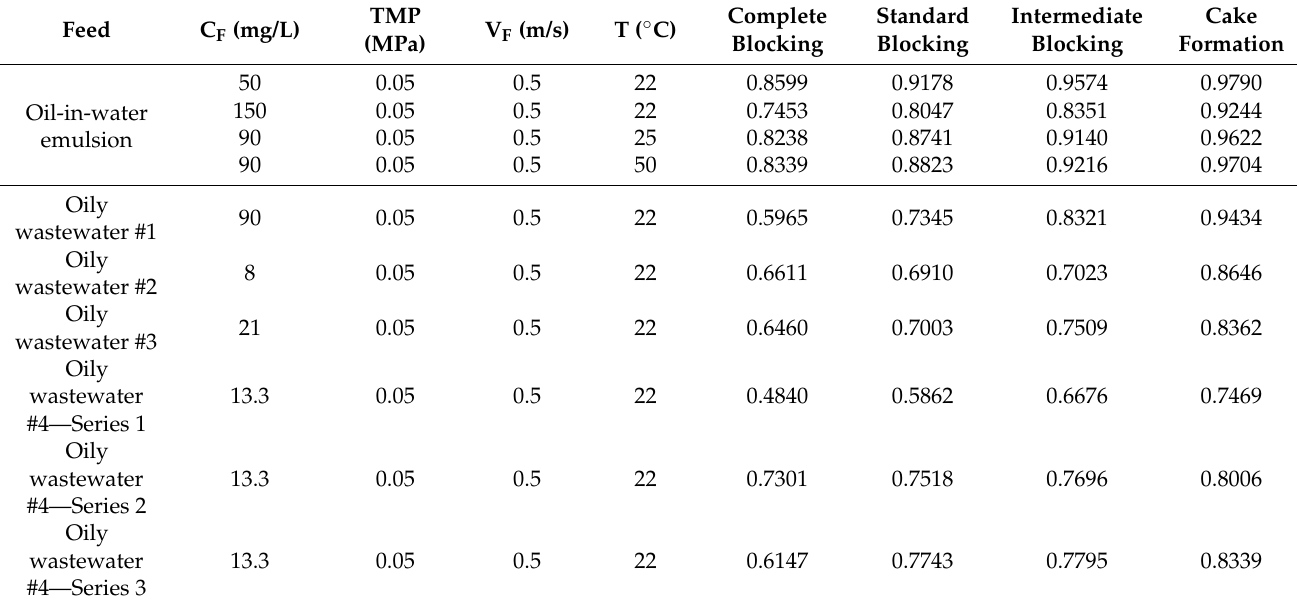
Table A1. Coefficients of determination ( R 2 ) for Hermia’s